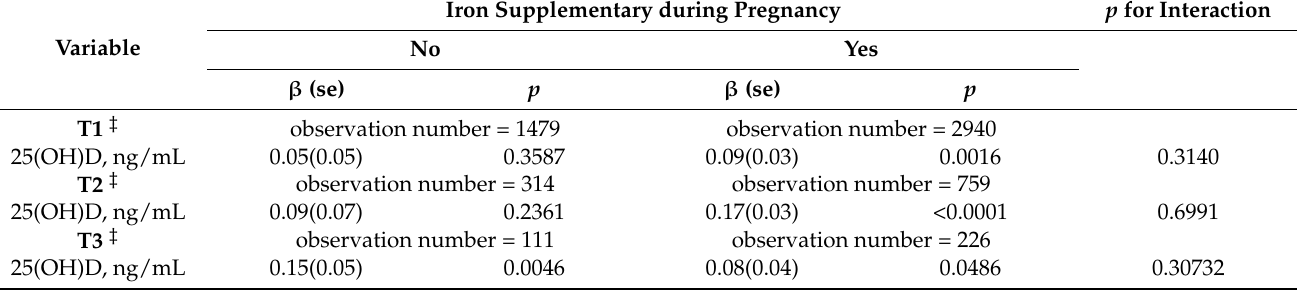
Table 3. The association * between 25(OH)D in different trimester and hemoglobin during pregnancy after corresponding 25(OH)D measurement, stratified by whether iron was supplementary during pregnancy or